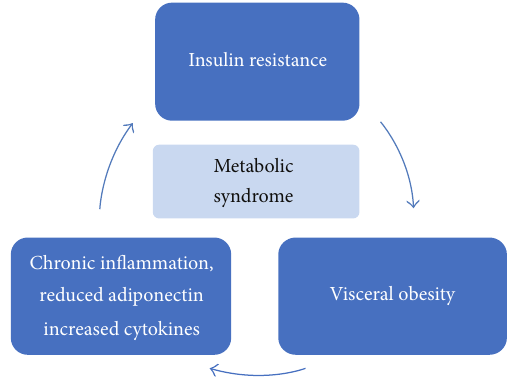
Figure 2: The pathophysiological loop of metabolic syndrome.